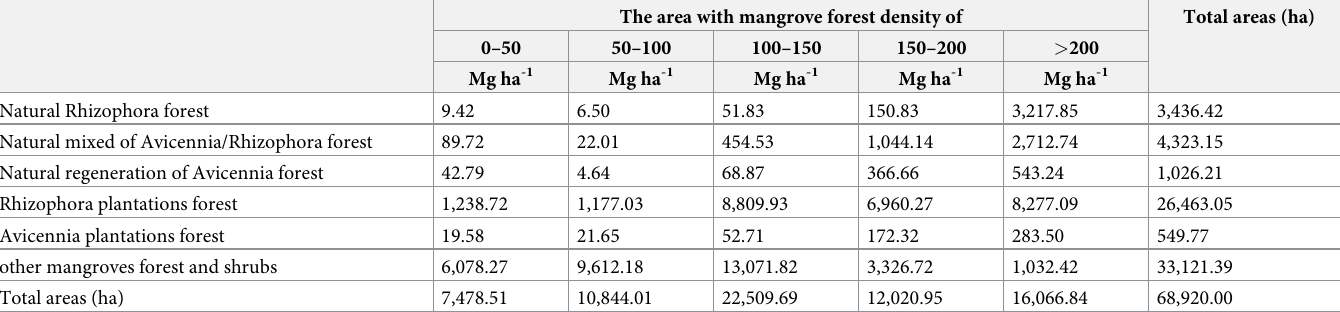
Table 7. The statistical results of the types of mangrove areas were classified into five ranges of aboveground biomass estimates. The area with mangrove forest density of Total areas